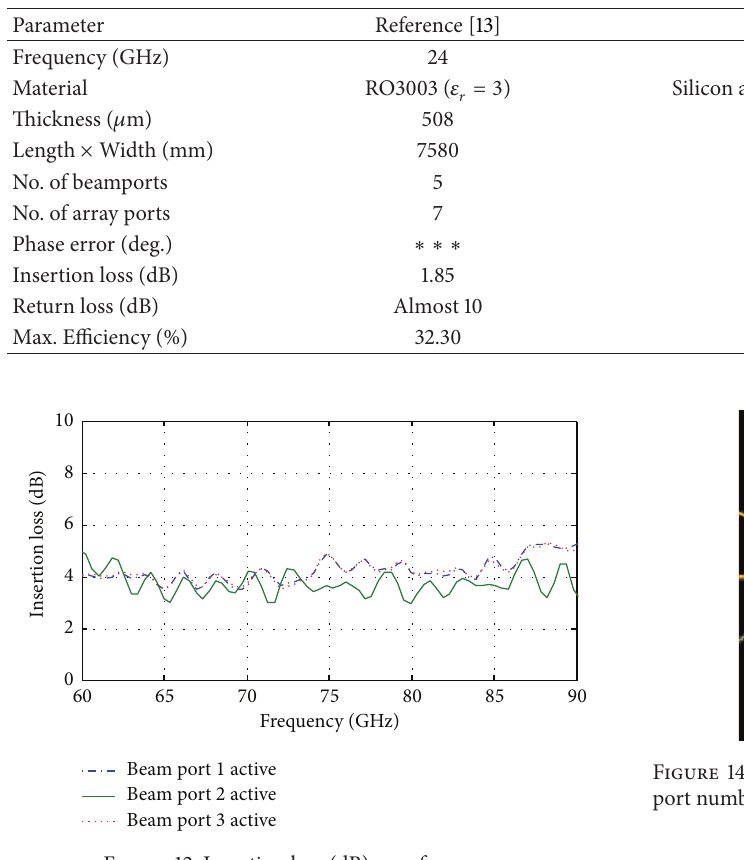
Figure 12: Insertion loss (dB) over frequency.